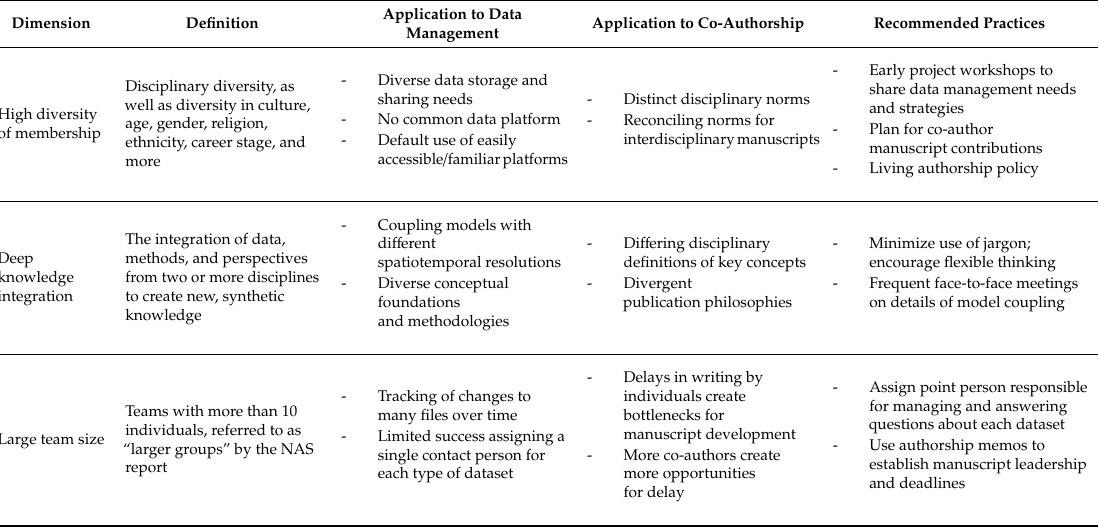
Table 1. Summary of challenges and lessons learned in each dimension of team science 1